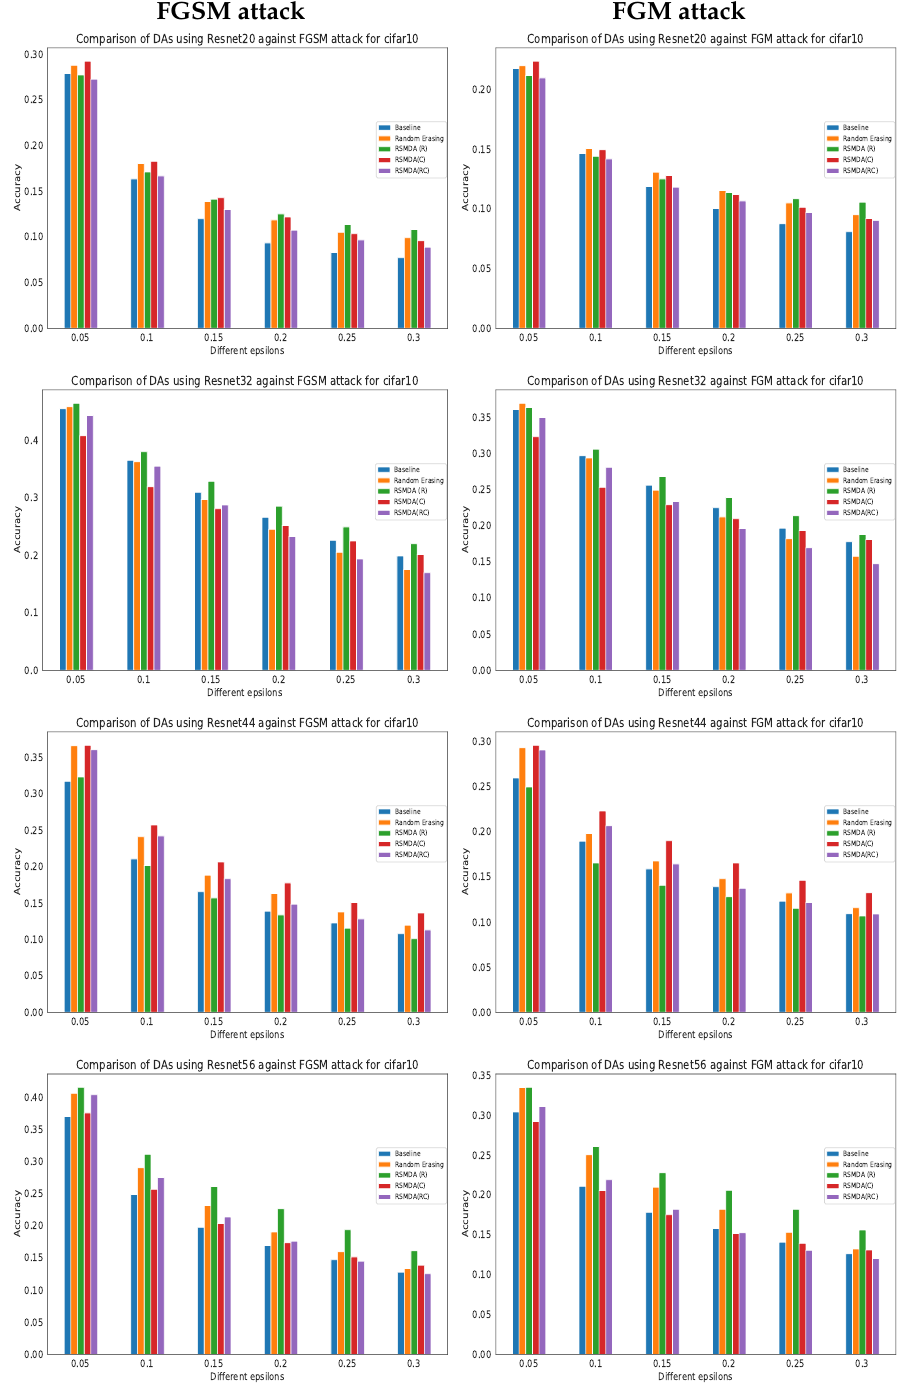
Figure 4. Comparison of DAs against different adversarial attacks for CIFAR10 dataset using different